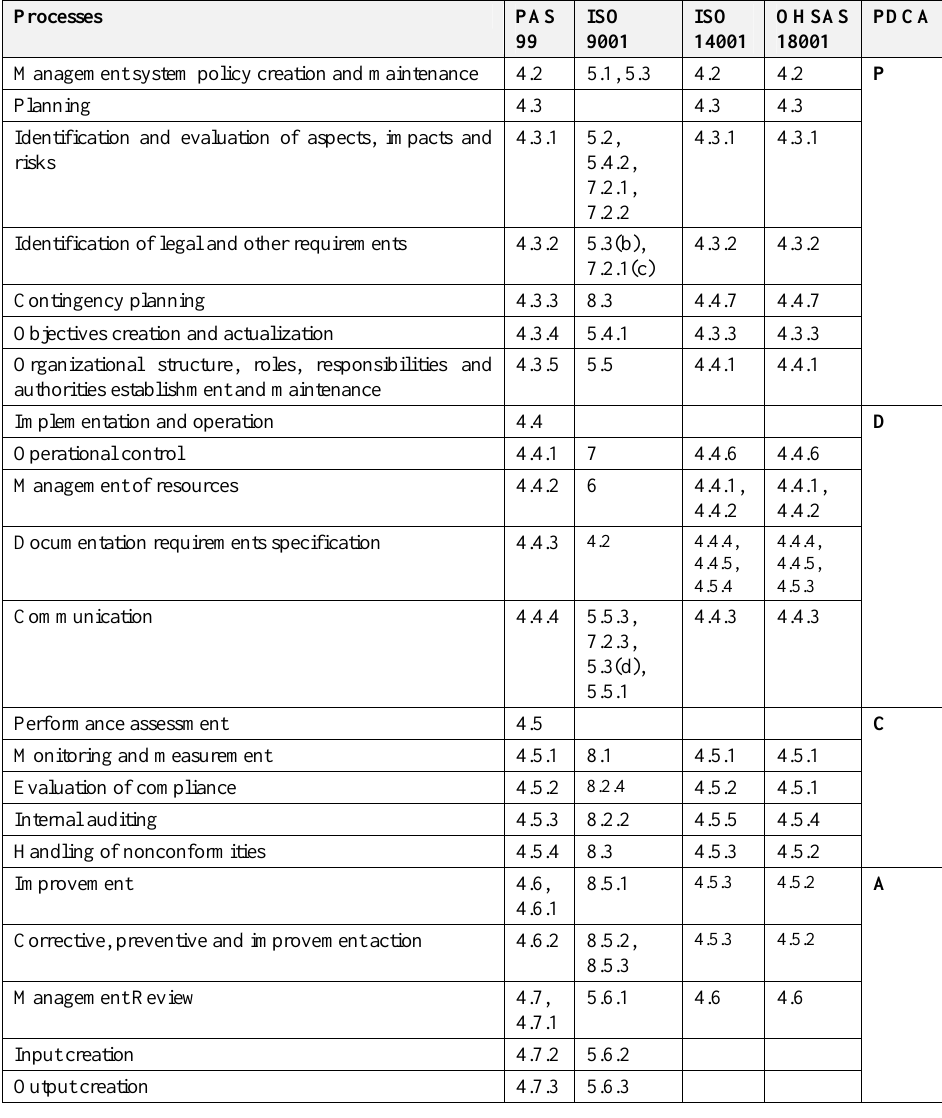
Table 1 – A simplified matrix of relationships between managerial processes and different elements of standards ISO 9001, ISO 14001 OHSAS